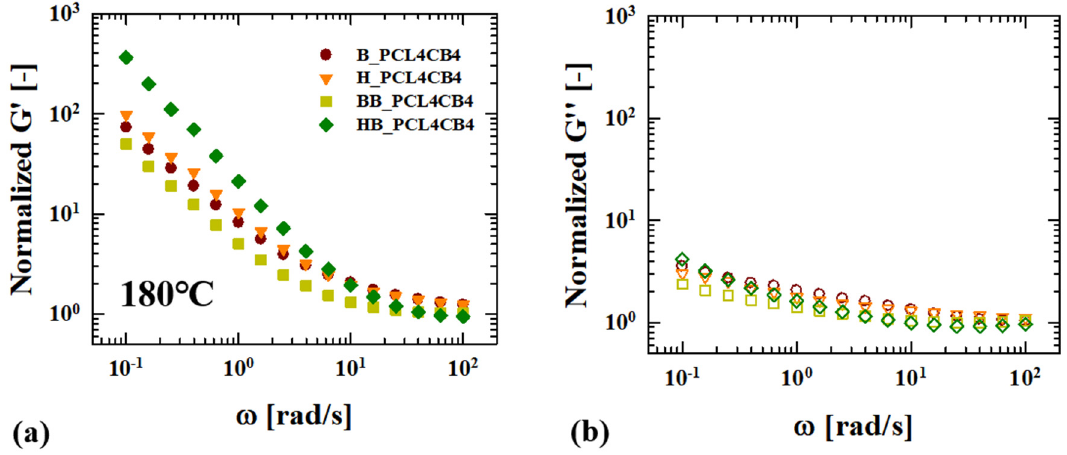
Figure 8. Linear viscoelasticity (G’, G”) of ternary composites depending on the mixing method at 180 °C: ( a ) The normalized storage modulus (G’) (normalized G’ = G’(ω(cid:4667) (cid:2913)(cid:2925)(cid:2923)(cid:2926)(cid:2925)(cid:2929)(cid:2919)(cid:2930)(cid:2915) / G’(ω(cid:4667) (cid:2886) (cid:2925)(cid:2928) (cid:2892)_(cid:2900)(cid:2896)(cid:2885) ) and ( b ) normalized loss modulus (G”) (normalized G’’ = G”(ω(cid:4667) (cid:2913)(cid:2925)(cid:2923)(cid:2926)(cid:2925)(cid:2929)(cid:2919)(cid:2930)(cid:2915) / G”(ω(cid:4667) (cid:2886) (cid:2925)(cid:2928) (cid:2892)_(cid:2900)(cid:2896)(cid:2885) ).